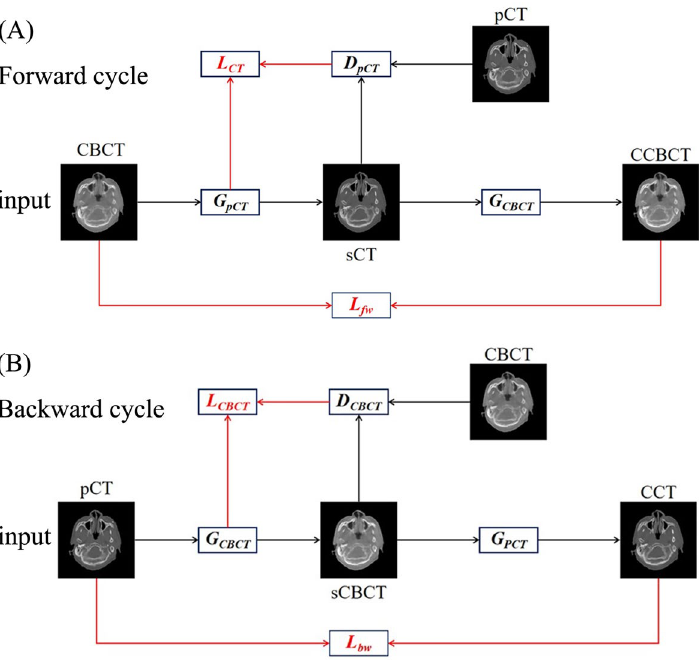
Figure 1. Illustration of cycle-consistent generative adversarial network